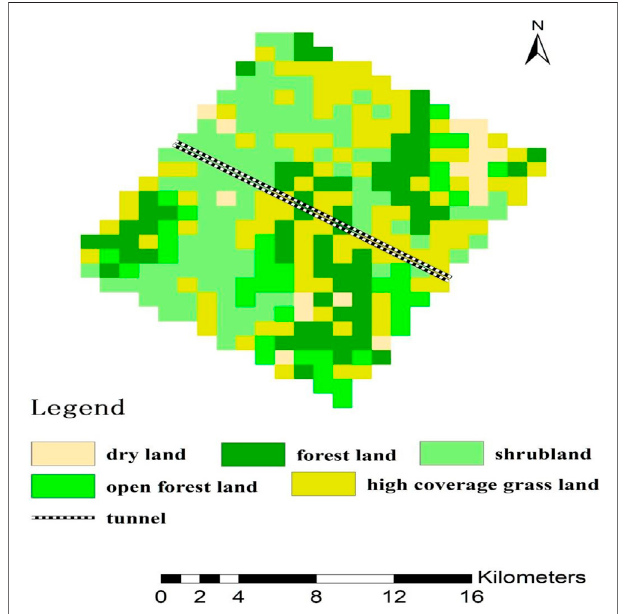
FIGURE 2 | Land cover map of the study